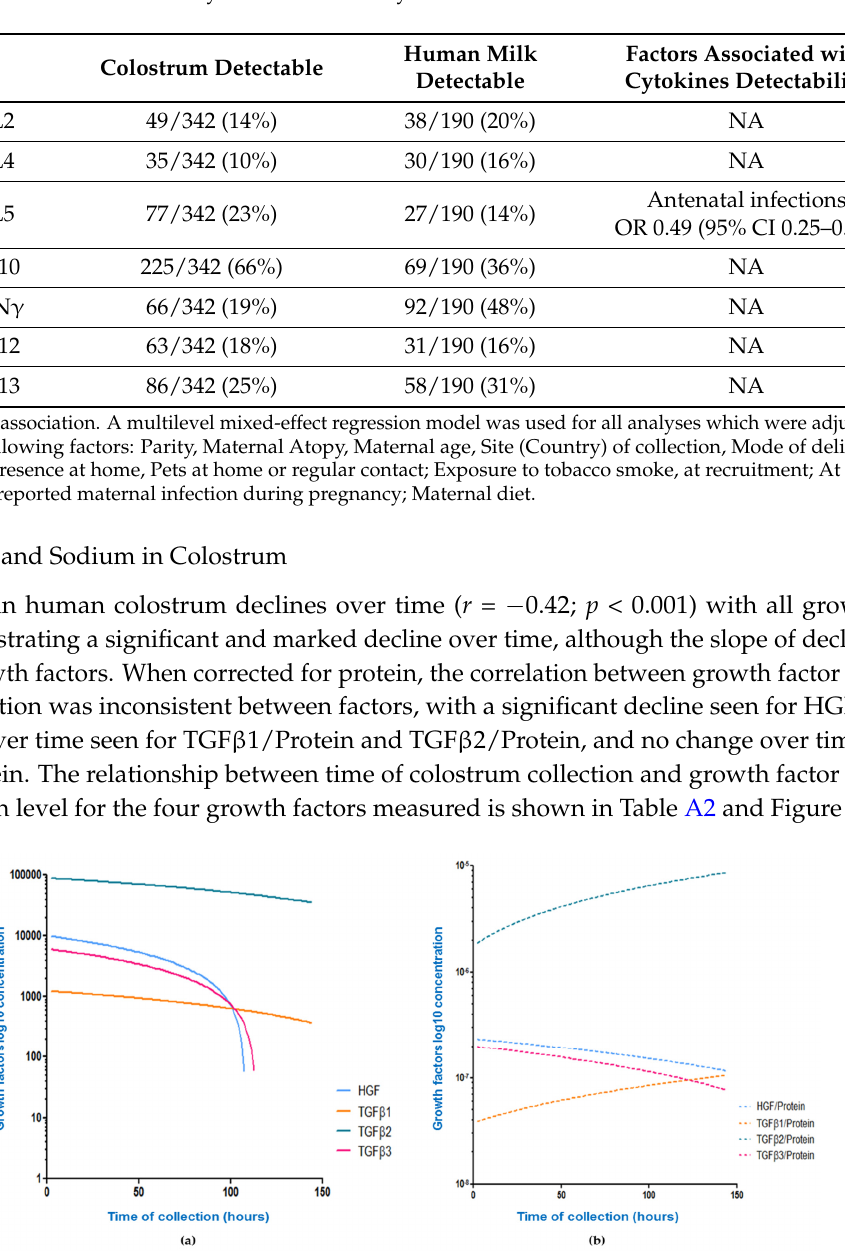
Table 4. Detectability of Th1 and Th2 Cytokines in Colostrum and Human Milk.